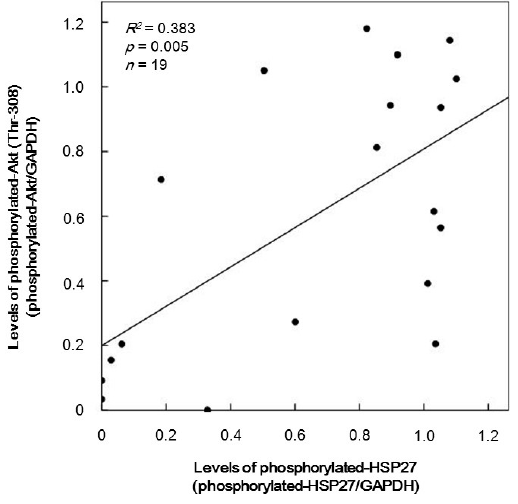
Figure 2. The relationship between individual levels of the phosphorylation of HSP27 (Ser-78) and Akt (Thr-308) induced by TRAP in platelets from type 2 DM patients. The baseline levels in unstimulated samples were subtracted from each level of the individual HSP27 phosphorylation and Akt phosphorylation stimulated by 10 µ M of TRAP for 4 min, and the net changes are presented as levels of phosphorylated-HSP27 (Ser-78) and phosphorylated-Akt (Thr-308), respectively. Each of the data were determined by a Western blot analysis using the ImageJ software program. These data were plotted and analyzed by linear regression